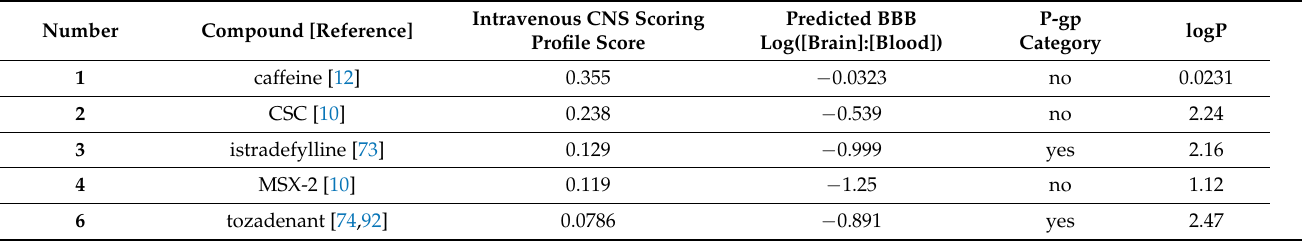
Table 2. Calculated MPO parameters of representative A 2A antagonists and one agonist 37 as shown in Figures 1 and 2, including compounds that are for use as PET tracers. The probabilistic scores indicative of CNS penetration were calculated for each small molecule with the StarDrop software package (Optibrium Inc., Cambridge, UK) [98,99]. Six physicochemical parameters that affect BBB passage are included in this calculation: molecular weight, most basic center’s p K a , calculated logP (clogP), calculated logD at pH 7.4 (clogD), topological polar surface area (tPSA), and hydrogen bond donor number. The BBB log([brain]:[blood]) (clogBB) parameter is a single indicator of probability of crossing the BBB at pharmacologically significant